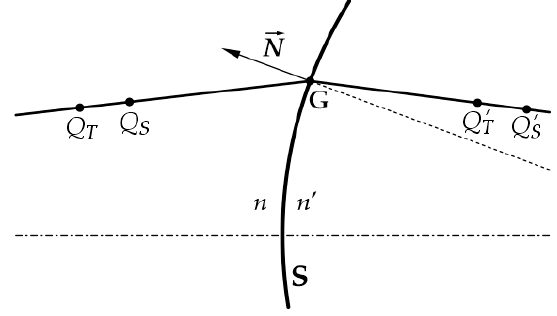
Figure 1. Ray refracting through a surface S.